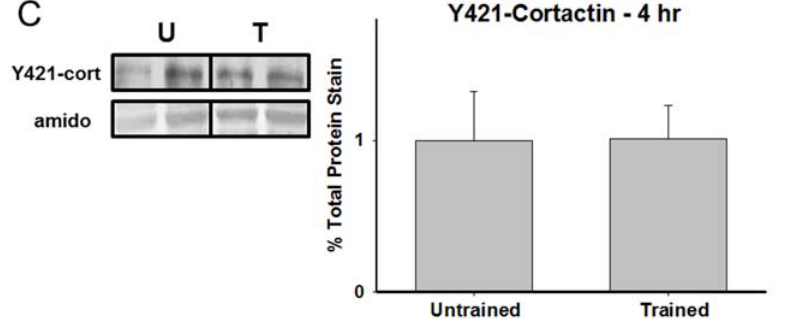
Figure 3. Y421-phosphorylated cortactin is reduced 30 min after RAM training. Representative samples and graphical depictions of group means for hippocampal Y421-phosphorylated cortactin (±SEM; expressed as percent of untrained controls) at 5 min, 30 min, and 4 h following RAM training. * p < 0.05 compared to